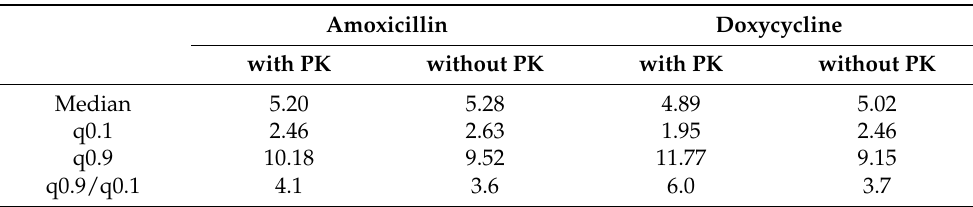
Table 2. Quantile of AUC_24h distribution (in mg h/L) computed with and without variability in individual PK parameters and considering all the AUC_24h values for all the individuals and all the first day of treatment. The PK variability has little impact on exposure for the less exposed animals, and a “medium” impact for the 10% most exposed